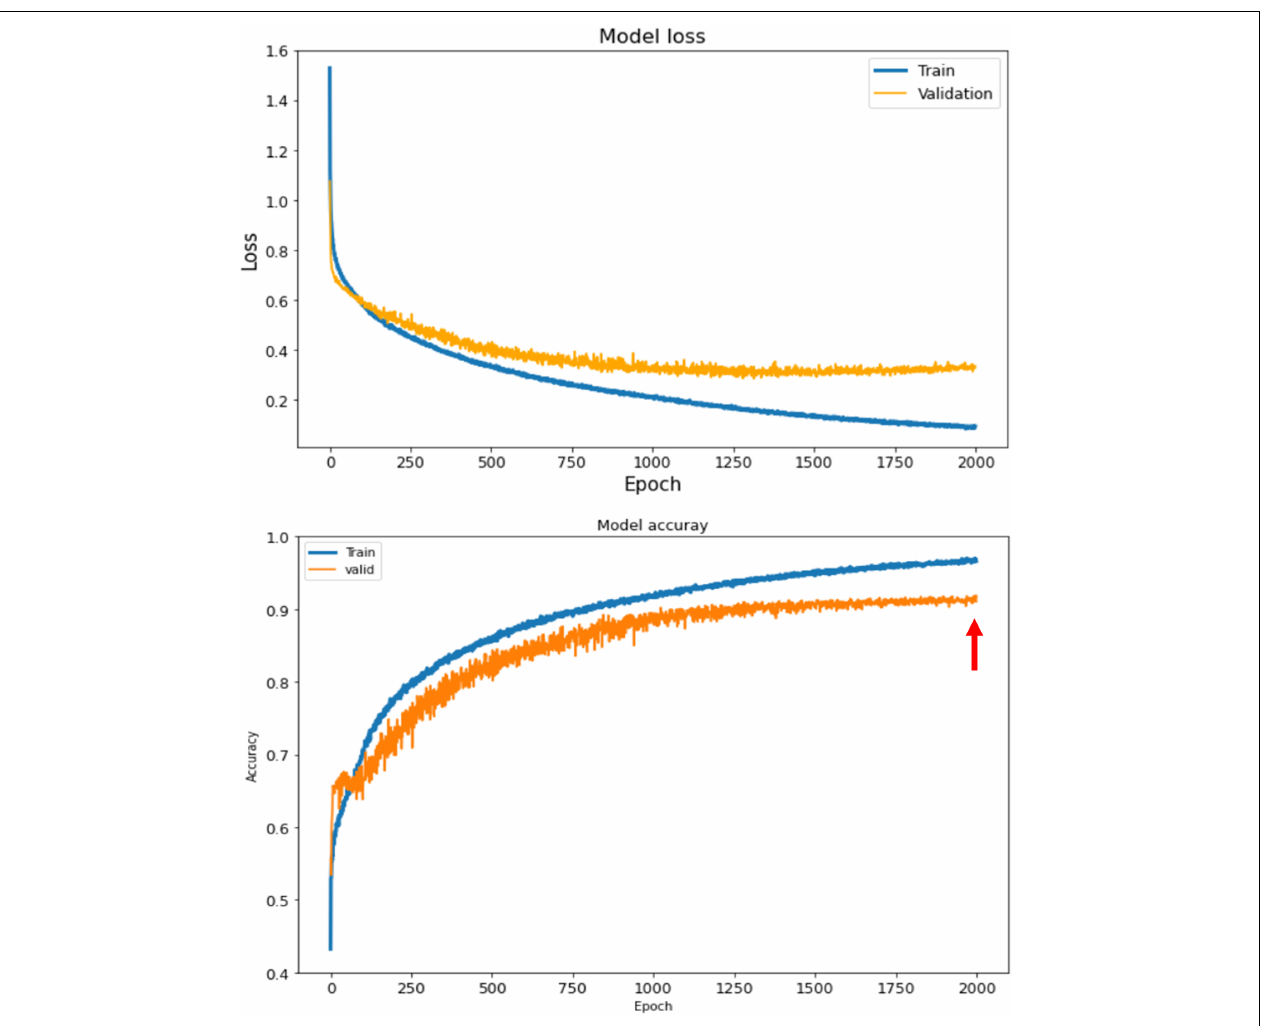
FIGURE 6 | The training history for ABCD dataset. The loss (top) and the accuracy (bottom) for train and validation sets. The best performing model is the model with highest accuracy on the validation set which happens at epoch 1999 shown by the red arrow.